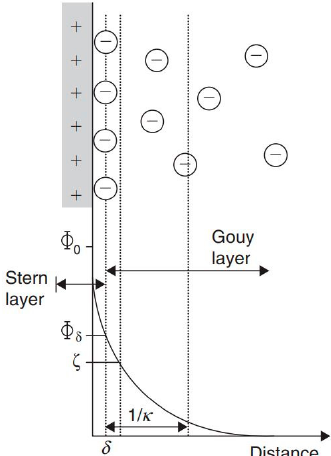
Figure 16. Stern model of the electric double layer (EDL) consisting of the Stern (compact) layer and the Gouy–Chapman (diffuse) layer. Reprinted with permission from ref. [179]. Copyright 2015 Elsevier.